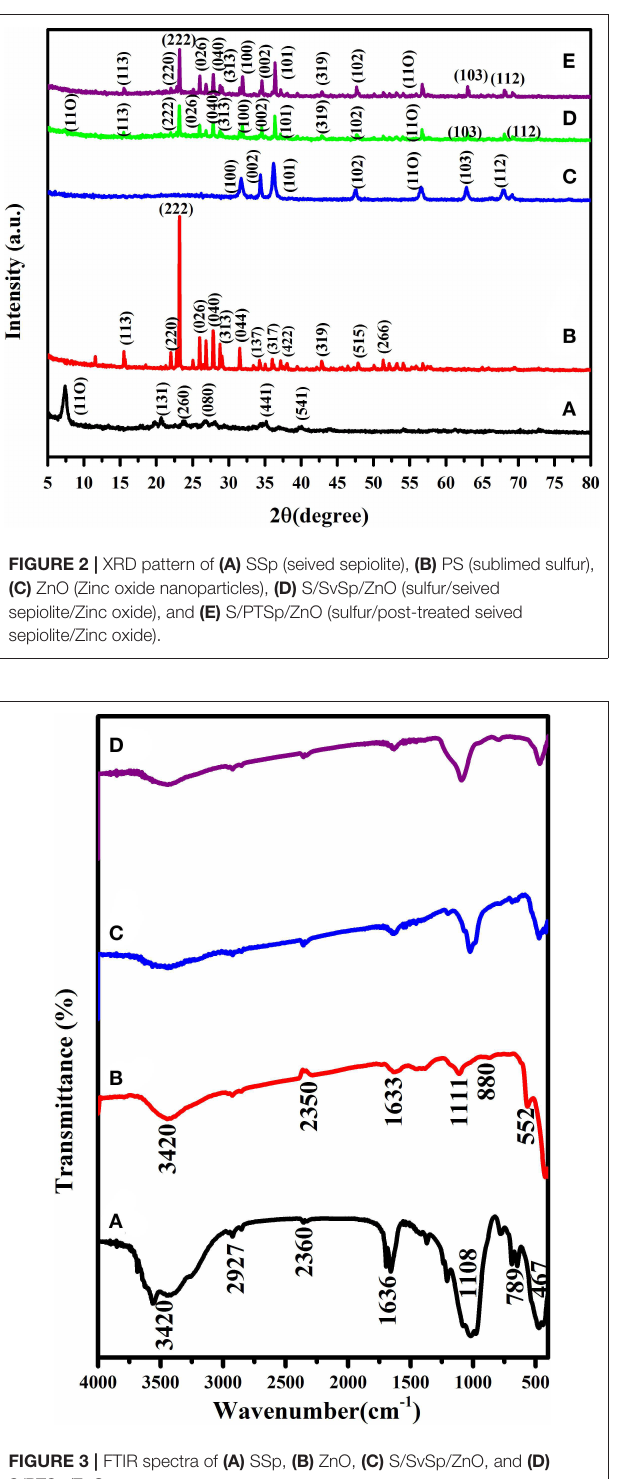
(PAN analytical XPERT-PRO with Cu-K α radiation) and FTIR